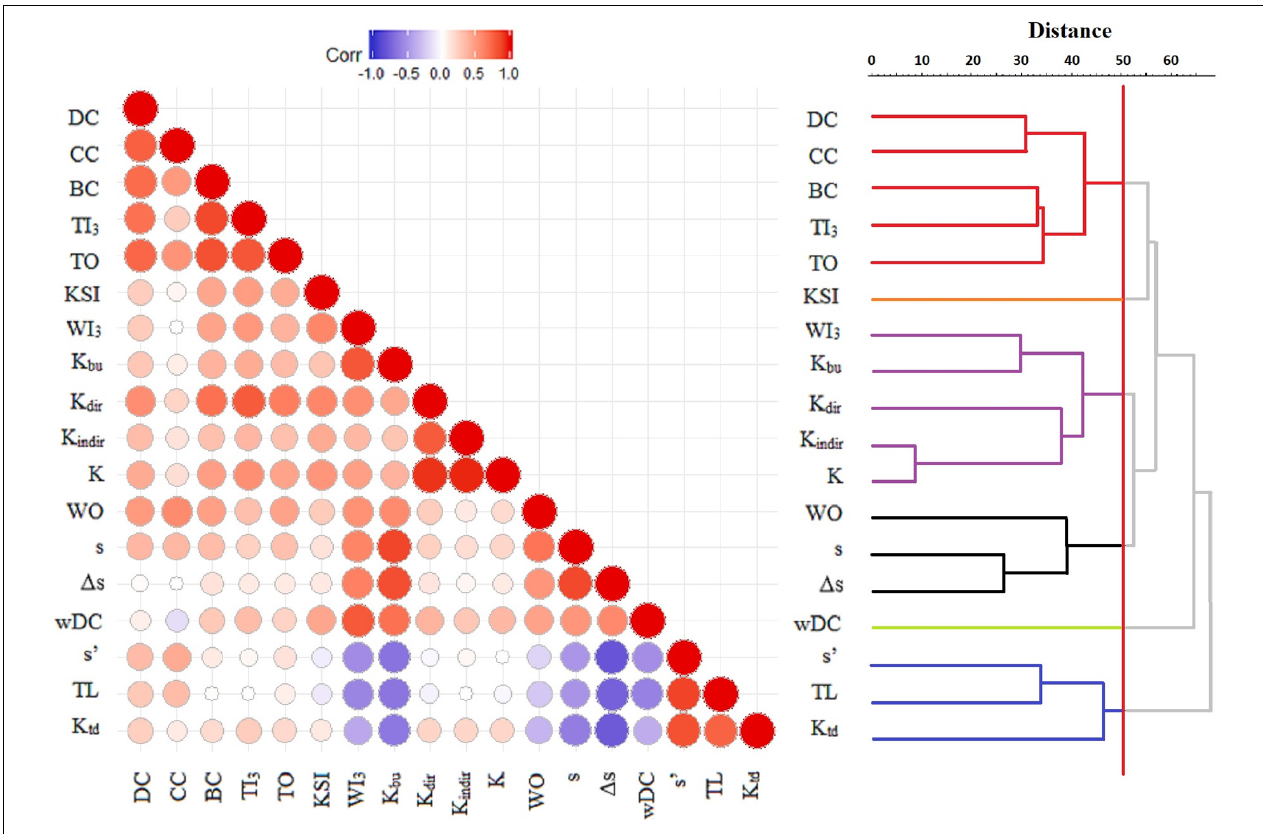
FIGURE 1 | Matrix plot of Spearman rank correlations among the 18 topological indices (left) and the UPGMA dendrogram based on Euclidean distances for standardized data. Negative correlations (e.g., between s (cid:48) and s) are shown in blue, while positive correlations (e.g., between DC and CC) are shown in red. The larger and darker the circle, the stronger the correlation. For the dendrogram, red vertical line denotes Euclidean distance at the level of 50, creating six clusters of indices ranking network nodes similarly in each